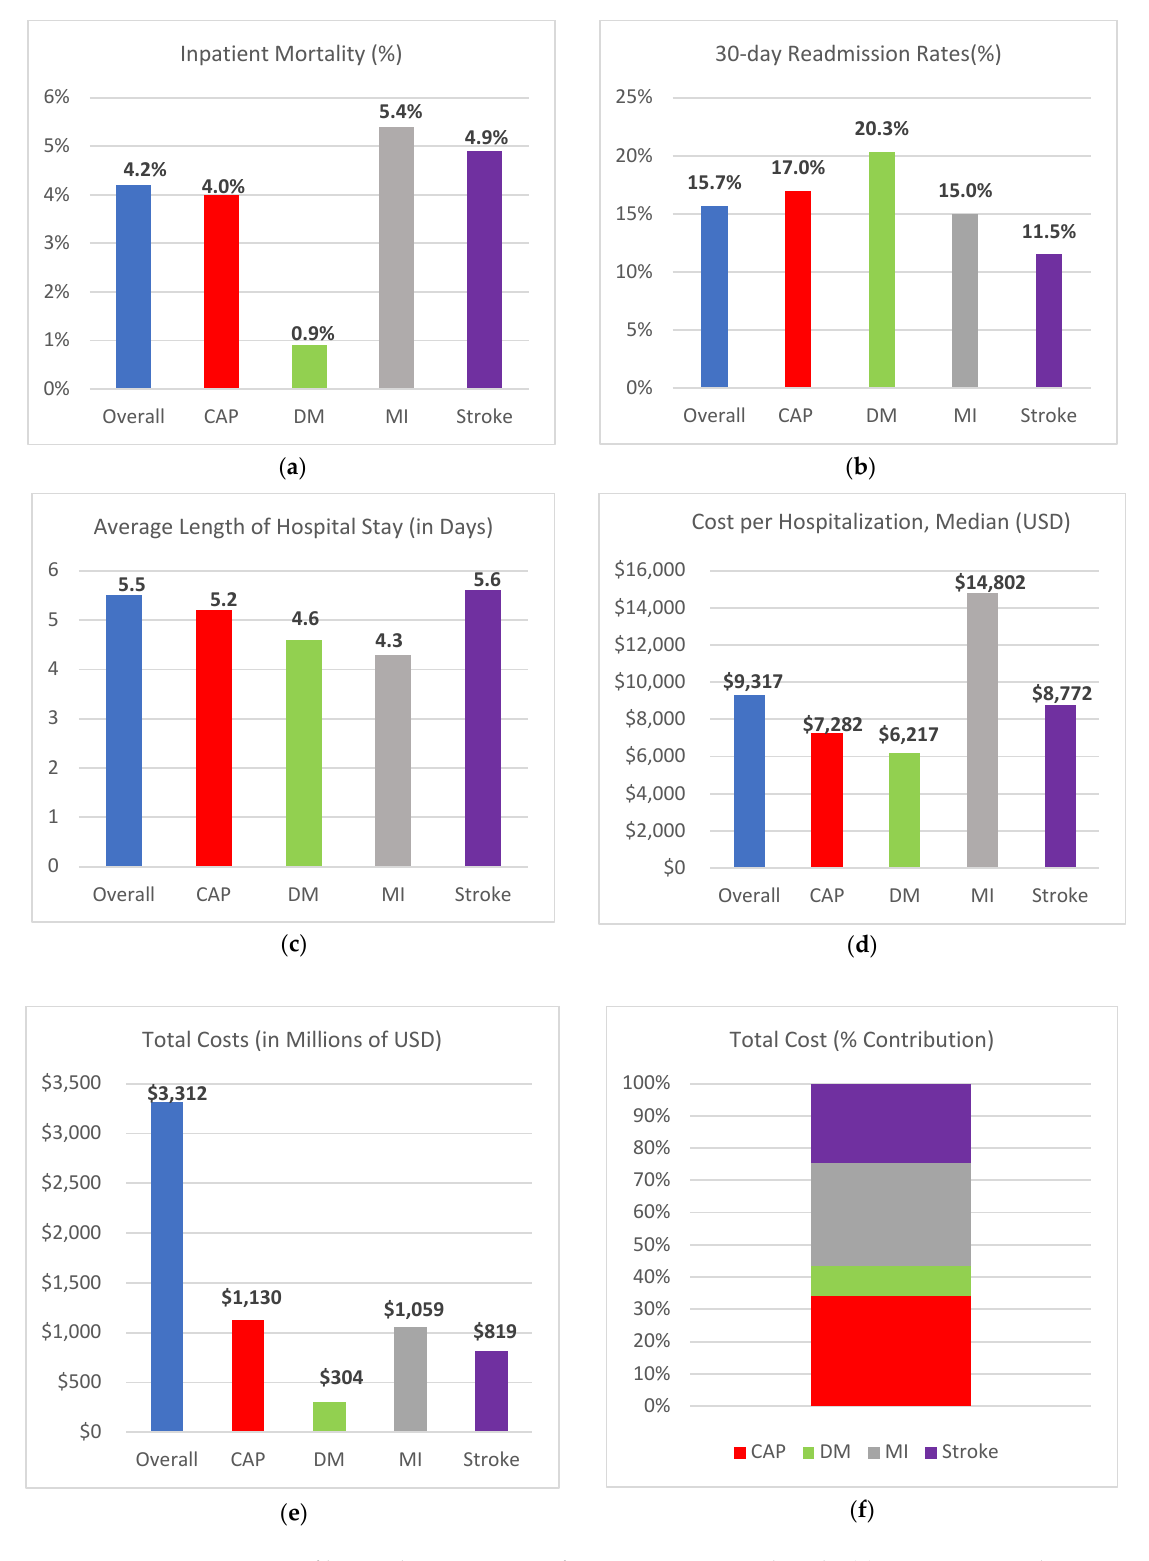
Figure 2. Comparison of hospitalization metrics for CAP, DM, MI, and stroke ( a ) Inpatient mortality; ( b ) 30-day readmissions rates; ( c ) length of hospital stay; ( d ) median cost per hospitalization; ( e ) total cost in millions of US dollars; ( f ) total cost in % contribution.